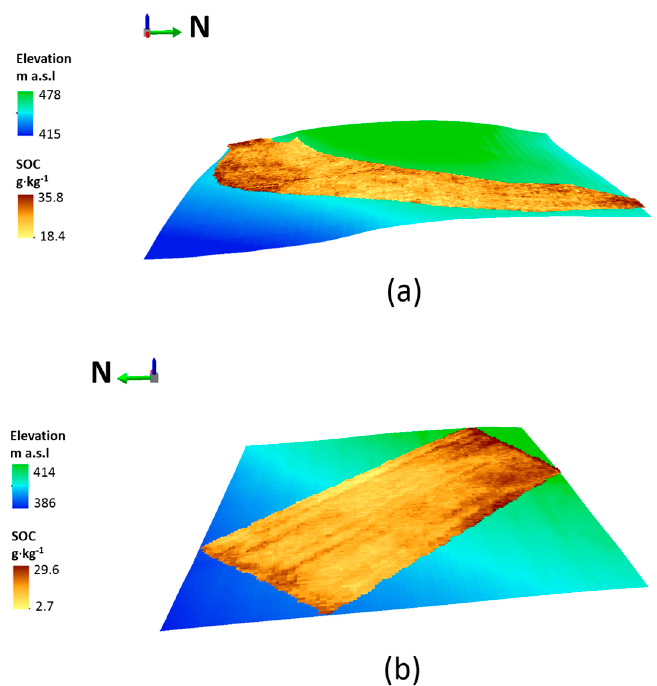
Figure 7. Soil organic carbon maps of the field 1 ( a ) and field 4 ( b ) obtained by the bottom-up approach in the loam belt area laid on top of the digital terrain model (DTM) of the Luxembourg region with a 5 m resolution.